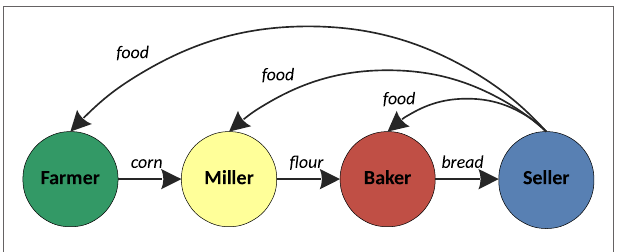
FigUre 1 | Food production cycle and dependencies between entrepreneurs of different types .